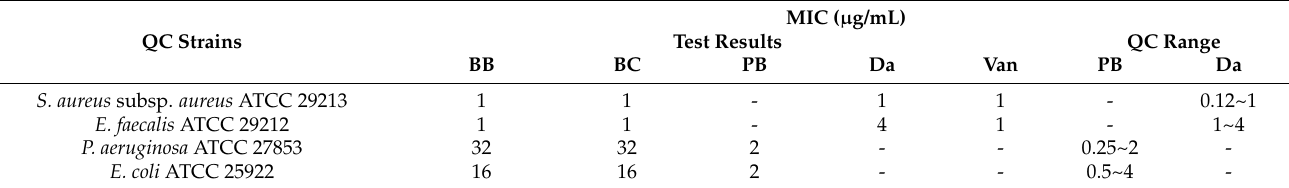
Table 1. Quality control of MIC determination system.